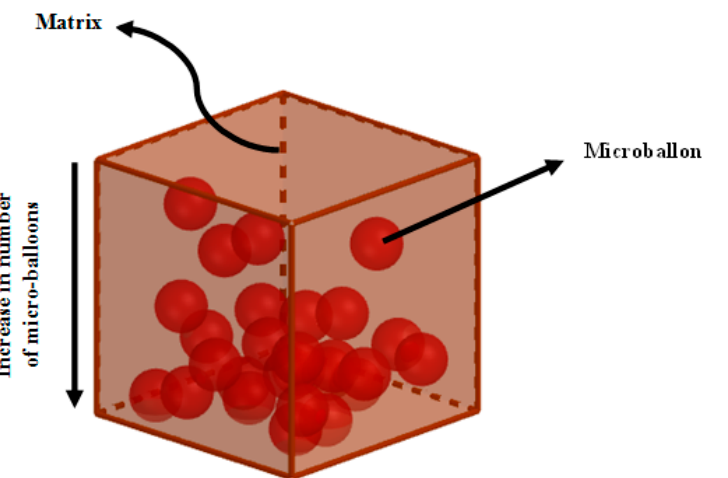
Figure 3. Schematic representation of a syntactic foam microstructure with spatially nonuniform embedded micro-balloons.